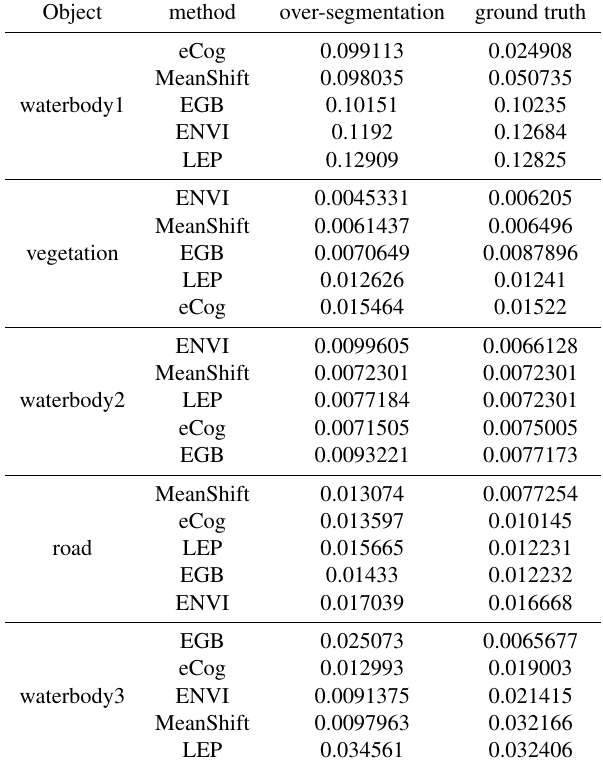
Table 1: GHD values of different algorithms for different objects The GHD represents the max-min geographic distance between the two point sets of the object boundary that are gotten by the manual delineation and automatic algorithm. With the reference of the ground truth segmentation, comparison of the GHD values for all algorithms with different objects shows that the segmen- tation accuracy is about 0.001km to 0.1km. For the GHD values of the same object, the difference between algorithms is tiny e- nough. The difference of the group of waterbody2’s GHD value is ± 0.0011km. Analogously the average difference between sev- eral algorithms in the group of road is nearly ± 0.0045km. For vegetation and waterbody3, the discrepancy is about ±